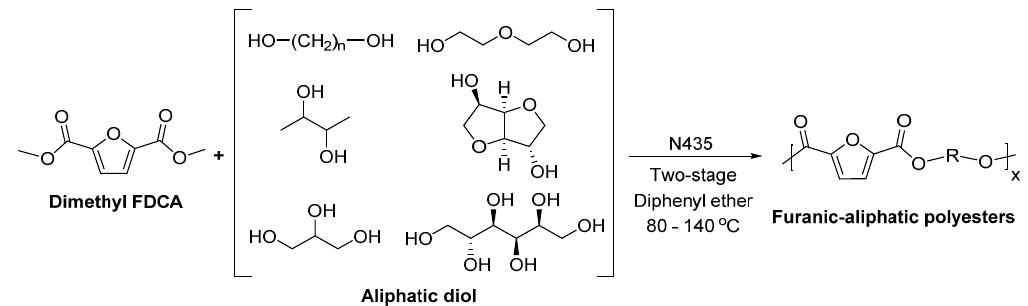
step method in diphenyl ether at 80 °C